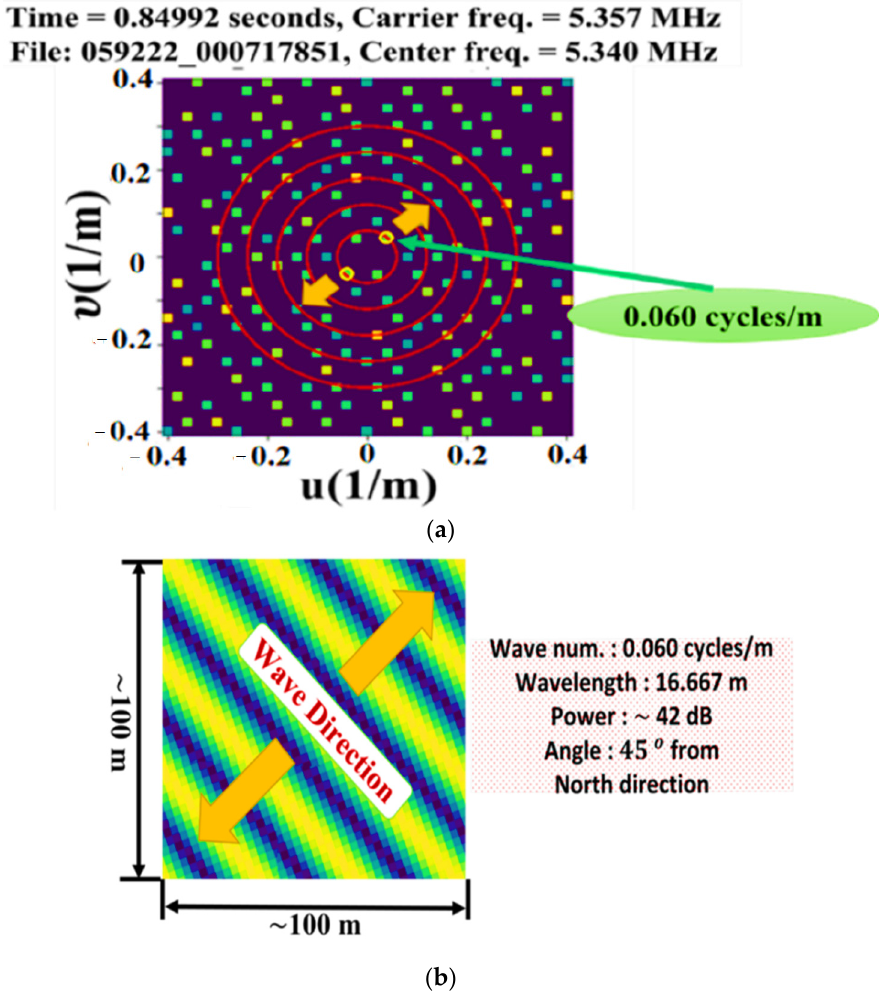
Figure 13. ( a ) A Fourier image of LWA-1 data with 0.06 cycles/m displaying a northeast–southwest wave vector direction of ~45 degrees eastward from the north–south direction. ( b ) Its IFT reveals the set of waves and its wave vector.